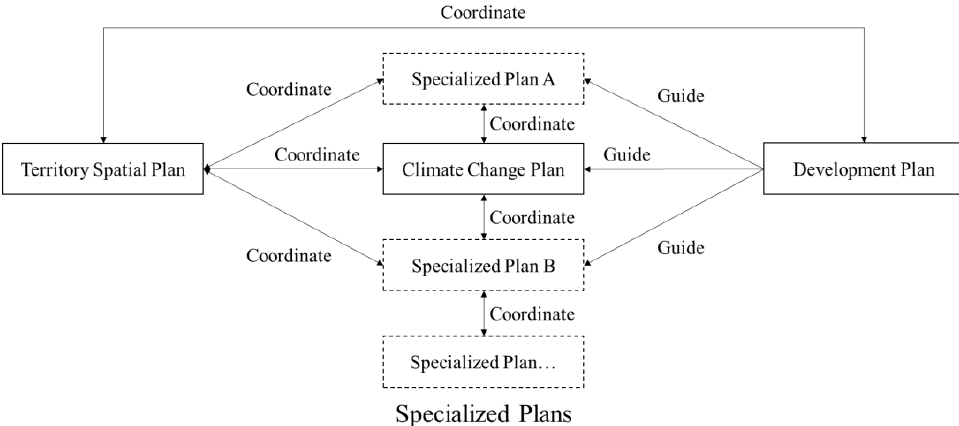
Figure 2. Relationships of the development plan, territory spatial plan and specialized plans on an individual level.